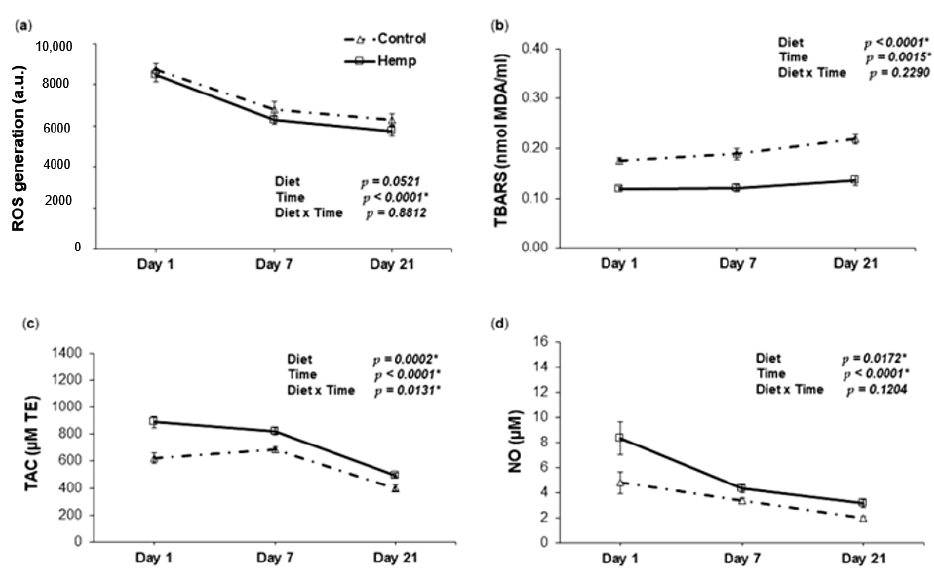
Figure 3. The effect of HD on oxidative status in the plasma of piglets throughout the lactation period. ( a ) Relationship between reactive oxygen species (ROS) and day of lactation in the plasma of piglets fed a control ( ∆ symbol) or a hemp seed diet ( (cid:3) symbol); ( b ) Relationship between TBARS and day of lactation in the plasma of piglets fed a control ( ∆ symbol) or a hemp seed diet ( (cid:3) symbol); ( c ) Relationship between total antioxidant capacity (TAC) and day of lactation in the plasma of piglets fed a control ( ∆ symbol) or a hemp seed diet ( (cid:3) symbol); ( d ) Relationship between NO and day of lactation in the plasma of piglets fed a control ( ∆ symbol) or a hemp seed diet ( (cid:3) symbol). The p -values for the effects of treatment (diet), time and diet-time interaction are shown. Data are means ± SEM ( n = 8). Asterisk (*) indicates significance ( p < 0.05